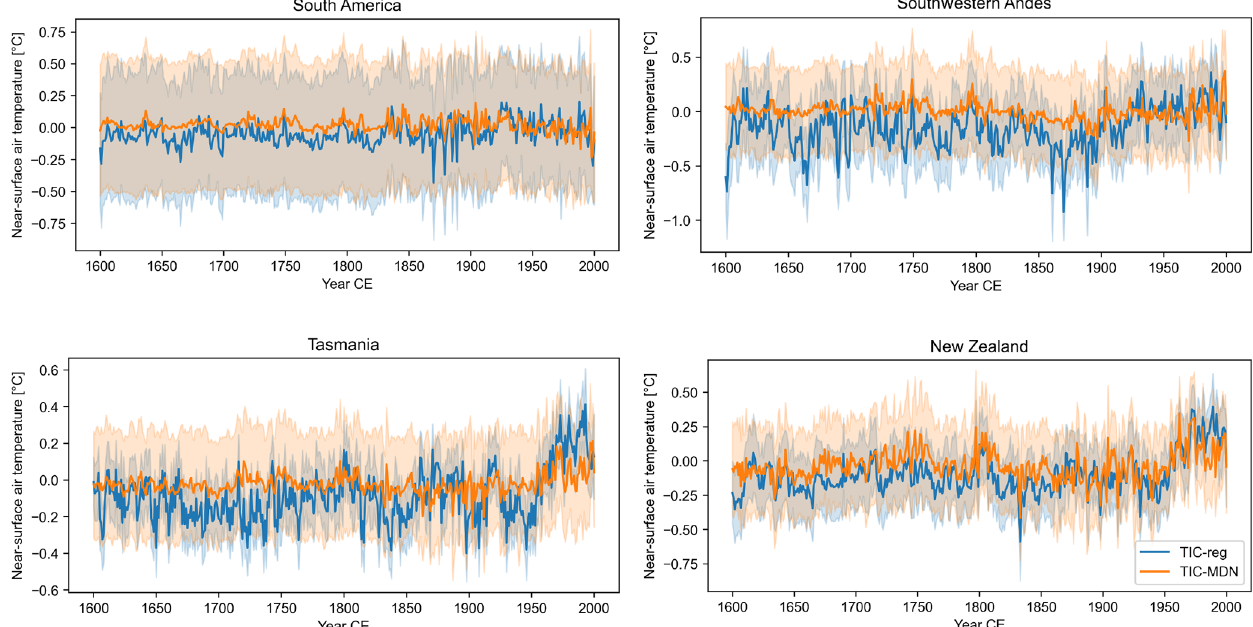
Figure 8. Reconstructed TIC-reg (in blue) and TIC-MDN (in orange) near-surface air temperature anomalies (in ◦ C; relative to 1901– 2000CE) over 1600–2000CE (Table 1) in different regions (Sect. 3). The uncertainty (i.e., the ensemble spread; Sect. 2.1) associated with each reconstruction is represented by the shaded areas.